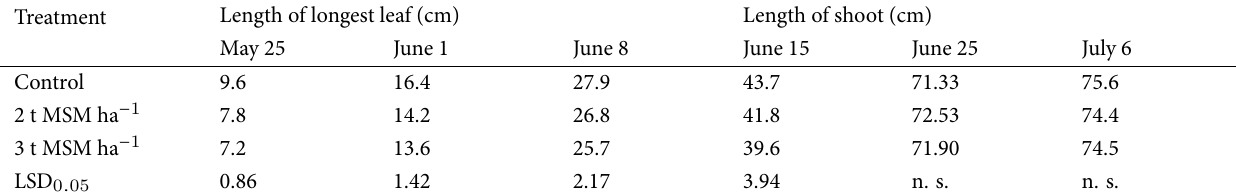
Table 2 Length of borage longest leaf and length of shoot relative to mustard seed meal dose and date of measurement. Treatment Length of longest leaf (cm) Length of shoot